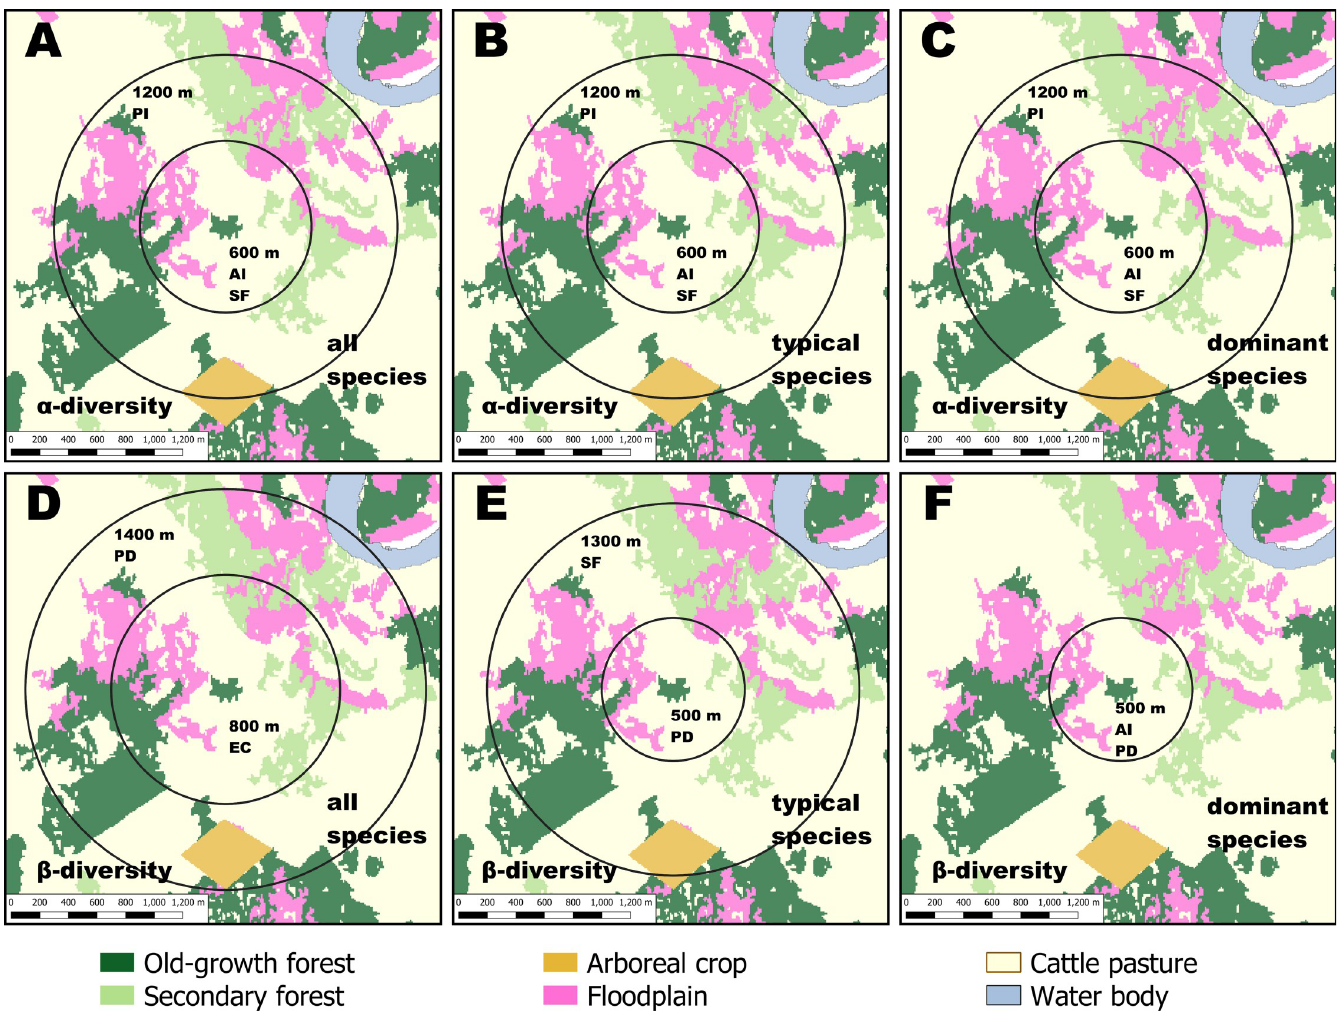
Fig 2. Scale of effect of landscape metrics on seedling diversity within forest patches in a fragmented tropical rainforest in southern Mexico. (A-C) Scale of effect on α -diversity. (D-F) Scale of effect on β -diversity. The landscape radius in meters and the associated landscape metrics are within each buffer. The landscape metrics are the aggregation index (AI), the edge contrast index (EC), the patch density (PD), patch isolation (PI), and the percentage of secondary forest